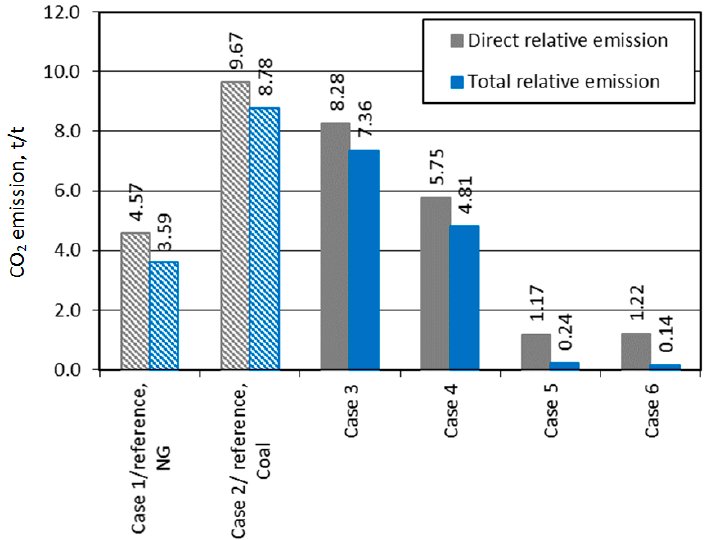
Figure 13. Consumption of hard coal and RDF and amount production of olefins.